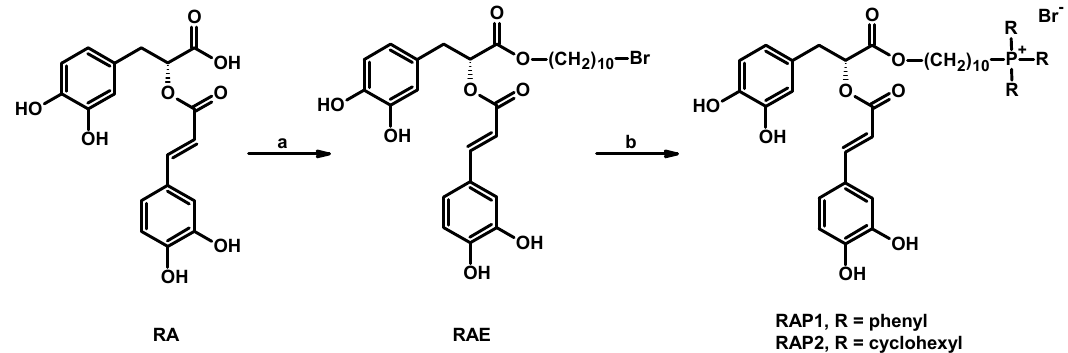
Scheme 1. Preparation of quaternary phosphonium salts derived from rosmarinic acid. Reagents and